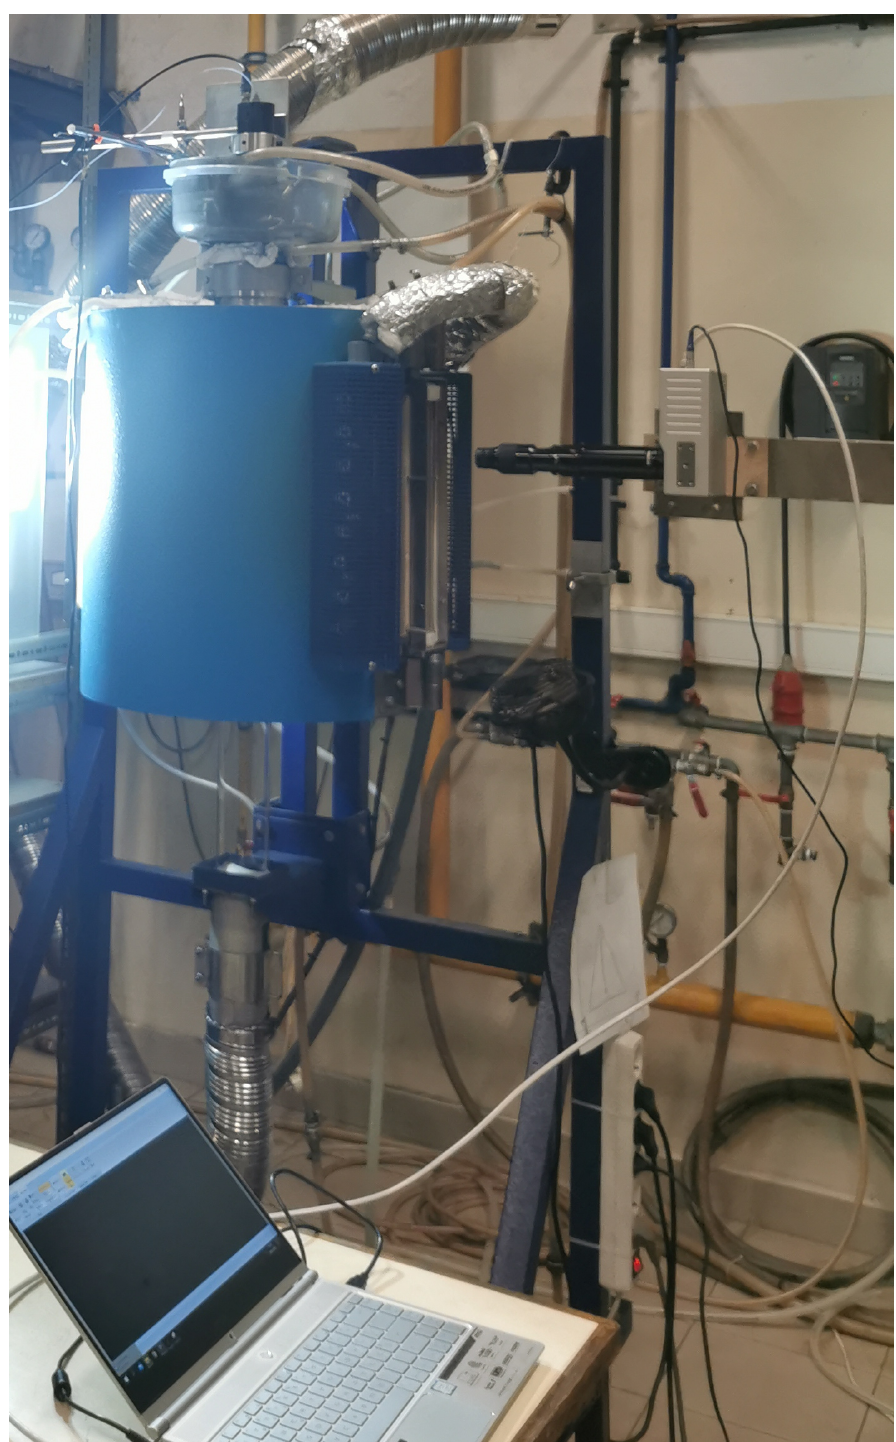
Figure A2. Experimental setup (side